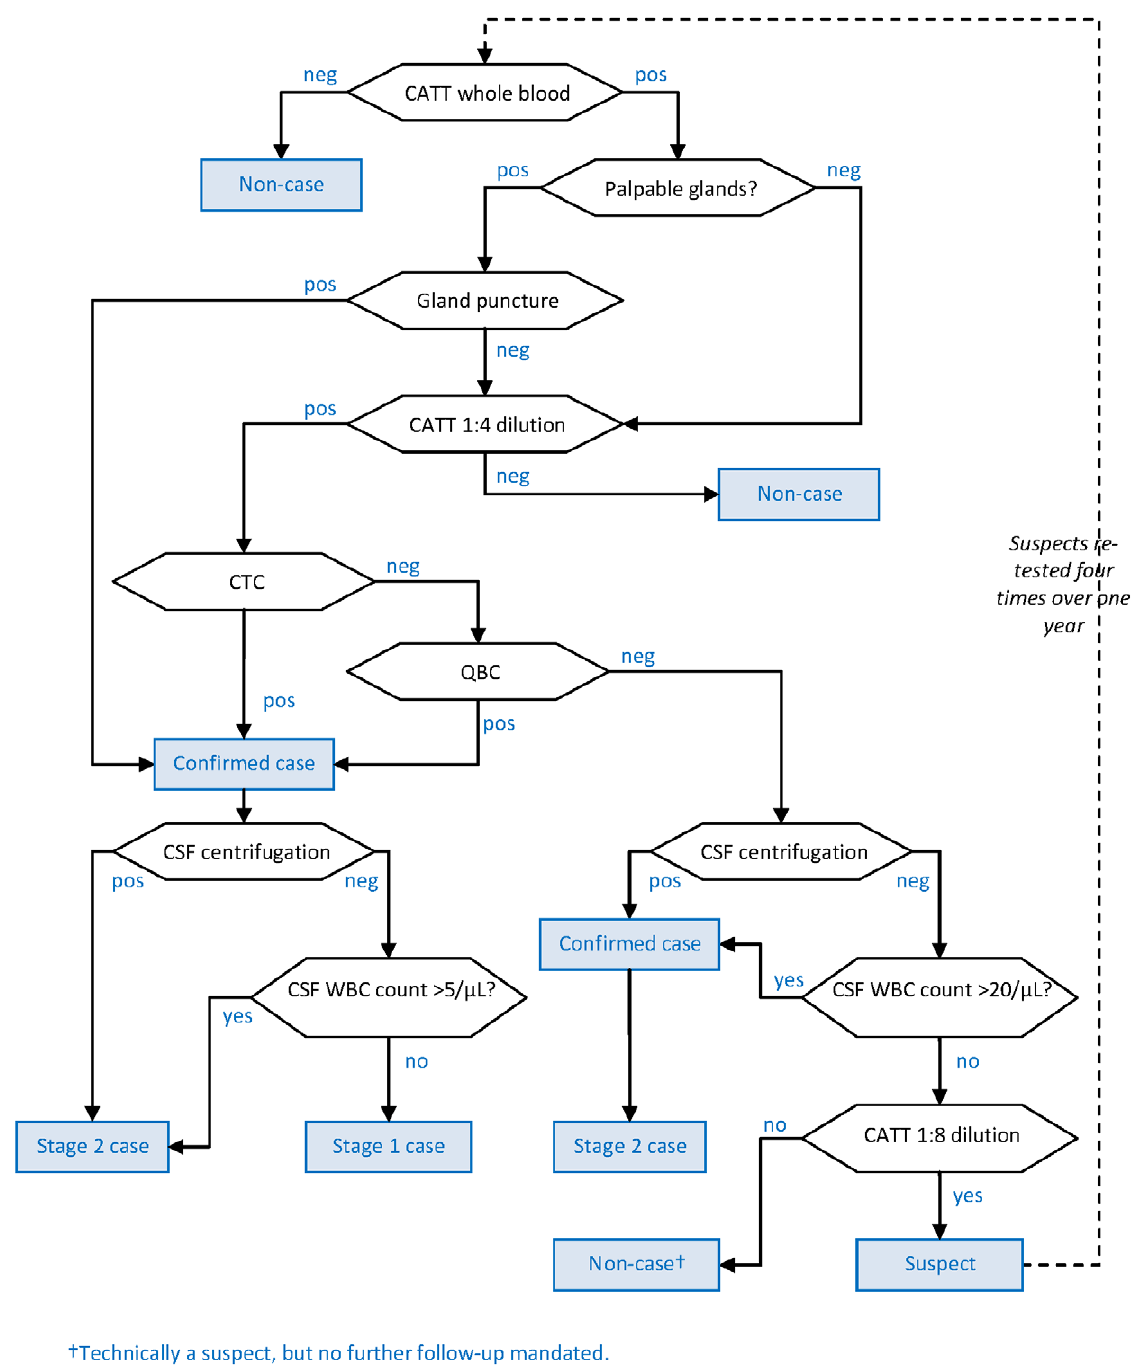
Figure 5. Diagnostic algorithm used by Arua-Yumbe programme, Uganda. Hexagonal boxes indicate tests. Square, blue-shaded boxes indicate points at which a decision on the patient is reached.